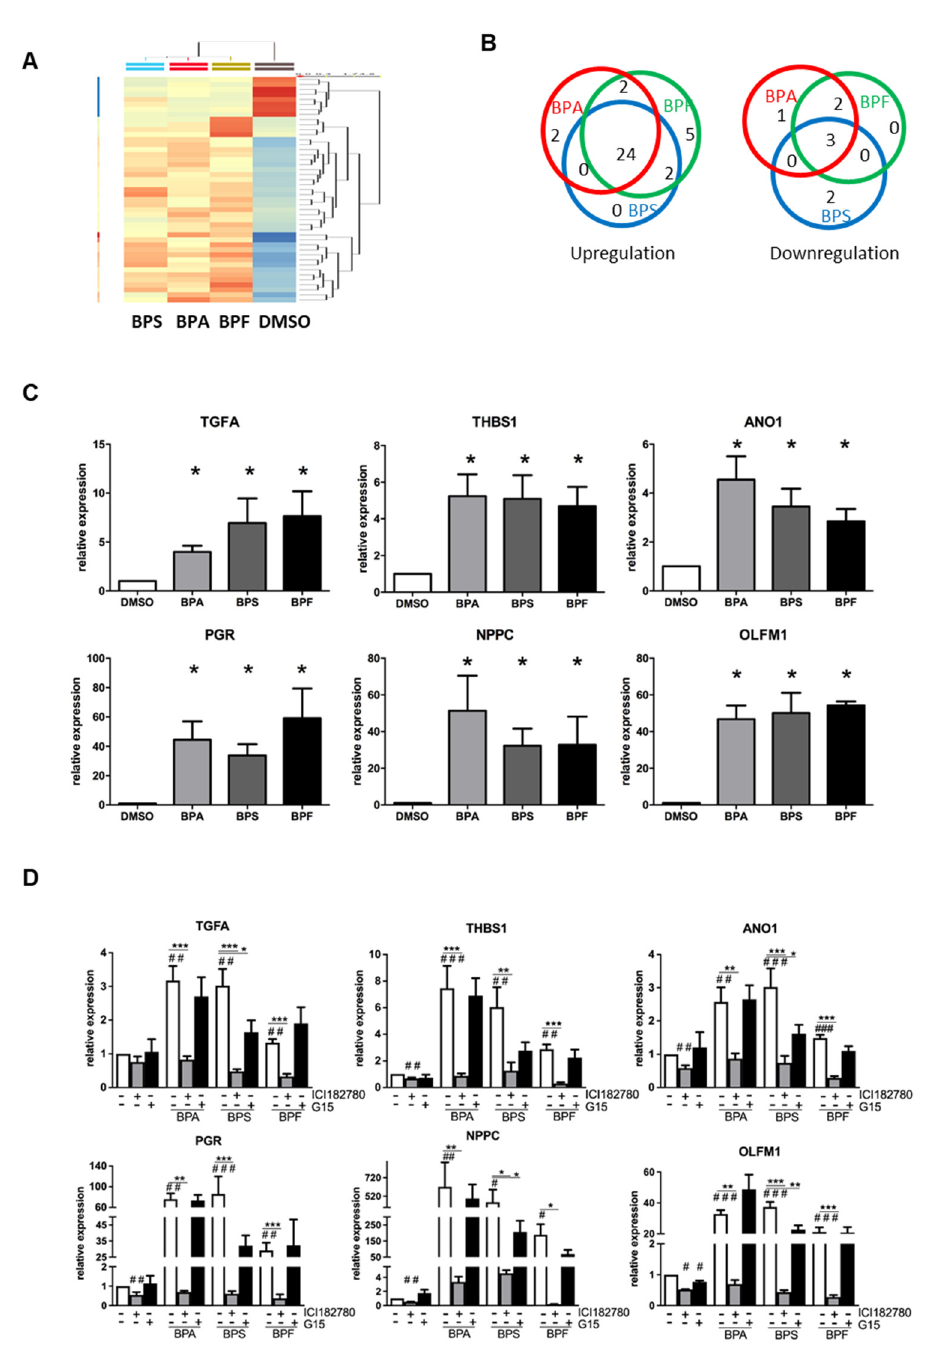
Figure 4. Microarray analysis of transcriptomic changes due to BPA, BPF, and BPS in Ishikawa cells. Ishikawa cells treated with 10 μ M BPA, BPS, and BPF for 24 h were analyzed by GeneChip Human Transcriptome Array 2.0 ( n = 3). ( A ) HeatMap clustering based on the similarity of regulated genes. ( B ) Venn diagram showing the number of differentially upregulated (left) and downregulated (right) genes in each treatment group compared with the DMSO control. Additionally, 24 out of 35 differentially upregulated genes and three out of eight differentially downregulated genes were found in all bisphenol treatments. ( C ) Six differentially expressed genes (TGFA, THBS1, ANO1, PGR, NPPC, and OLFM1) found in all bisphenol treatments were selected for qPCR validation ( n = 7). * denotes significant differences from the DMSO control at p < 0.05. ( D ) Estrogen receptor antag- onist (ICI 182,780 and G15) reversed the expressions of the six differentially upregulated genes in- duced by bisphenols. Ishikawa cells treated with 10 μ M BPA, BPS, or BPF with or without 1 μ M ER antagonists (ICI 182,780 and G15) for 24 h. qPCR analysis confirmed ICI 182,780 alone suppressed the expression of endogenous THBS1, ANO1, PGR, NPPC, and OLFM1 transcripts, and G15 also